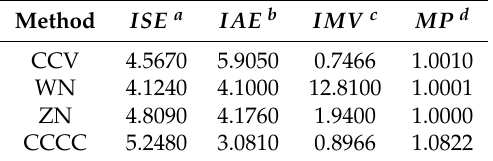
Table A5. Performance indexes. Set-point tracking for the set P 2 .